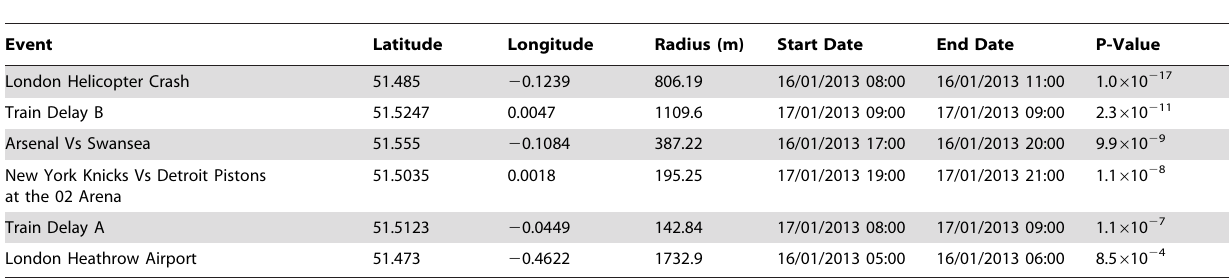
Table 6. Identified hourly cluster attributes derived via space-time scan statistics.